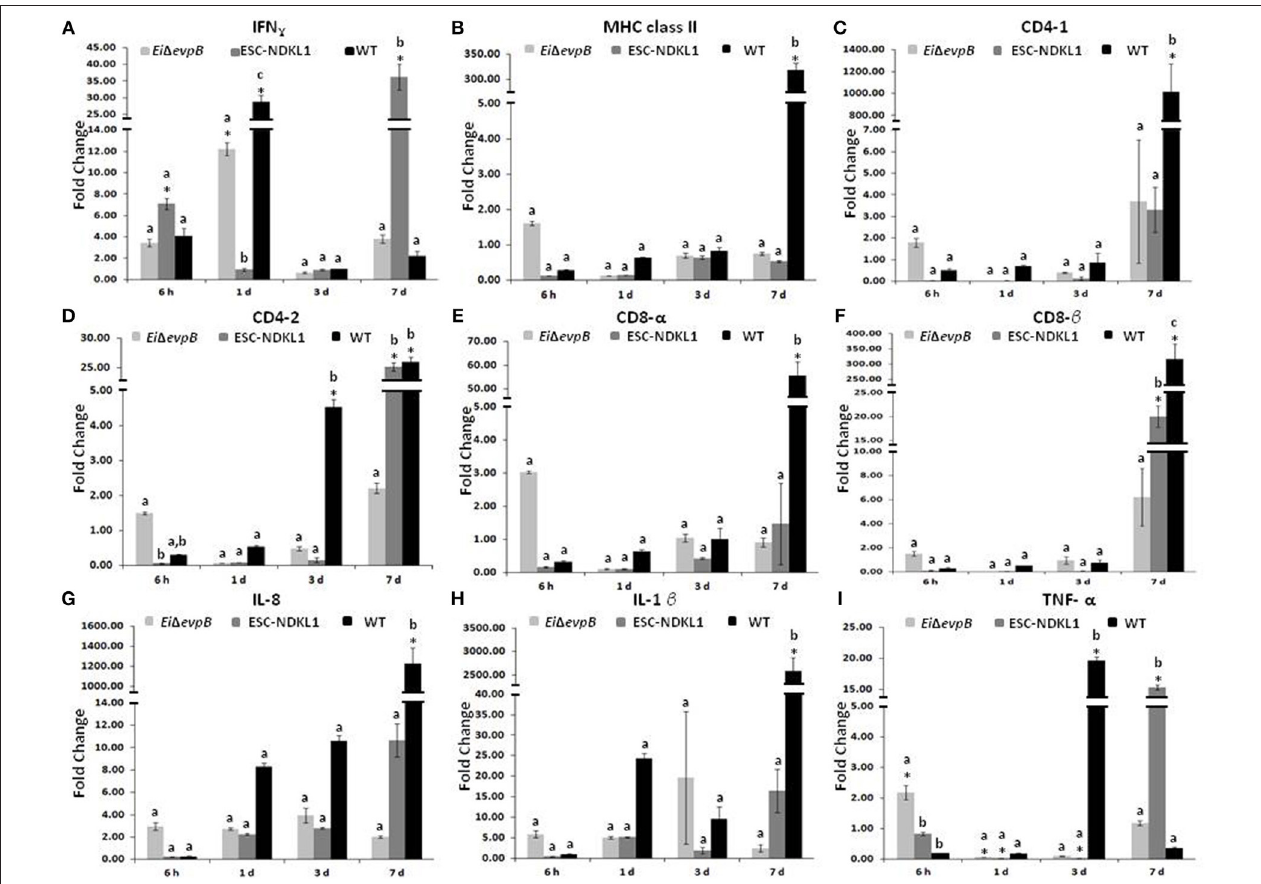
FIGURE 4 | Changes in the expression of IFN- γ (A) , MHC class II (B) , CD4-1 (C) , CD4-2 (D) , CD8- α (E) , CD8- β (F) , IL-8 (G) , IL-1 β (H) , and TNF- α (I) genes in the spleen of catfish challenged with E. ictaluri LAV and WT strains. Data are presented as fold difference of gene expression compared with values obtained for control uninfected cells. Samples were analyzed in triplicates from a pull of spleen of six fish and presented as mean ± SD. *Indicates significant differences compared to uninfected control ( p < 0.05). abc Indicates differences within each time point ( P <